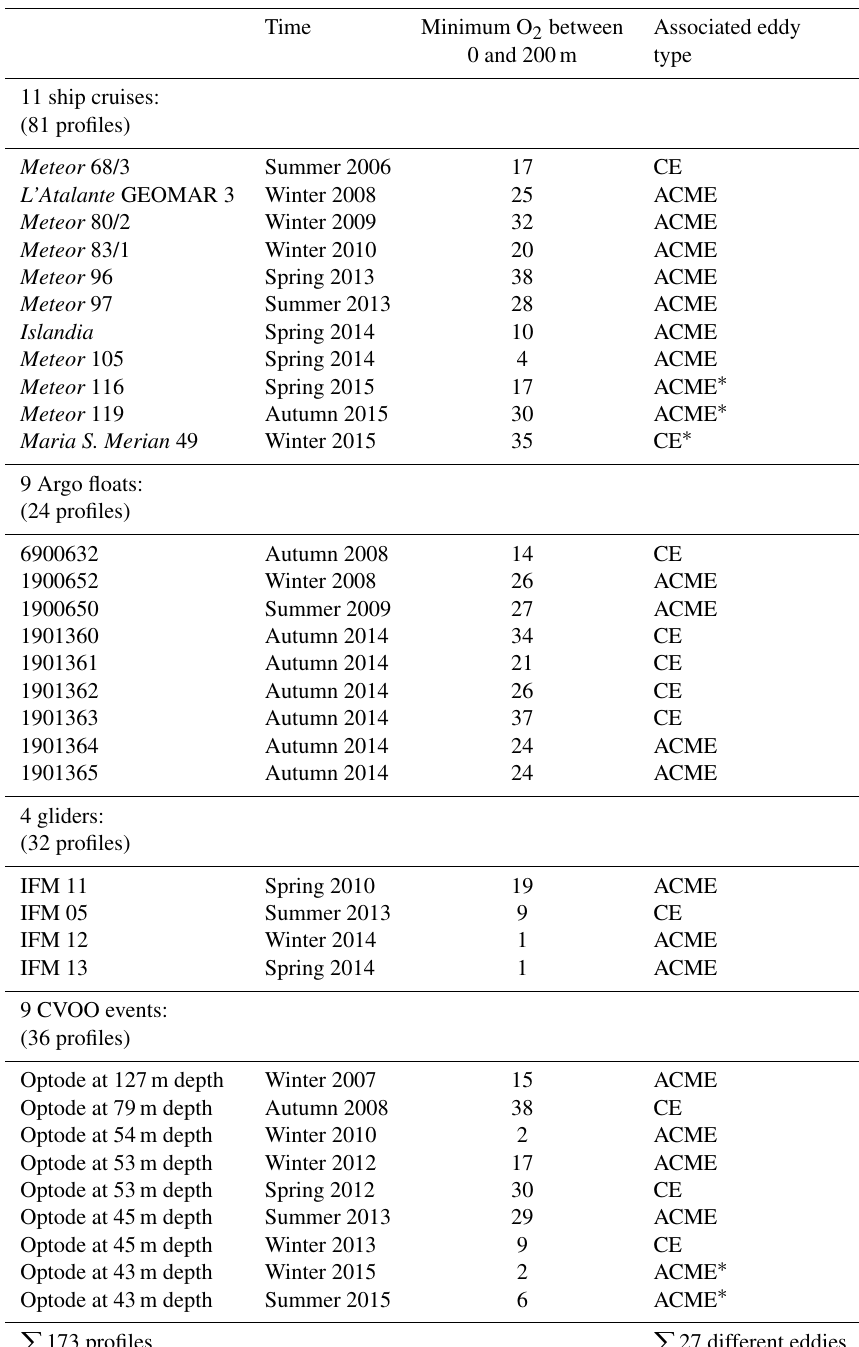
Table 1. Available oxygen measurements below 40µmolkg − 1 in the ETNA. The ∗ indicates recent observations which are not included in Fig. 4 due to not existent delayed time satellite